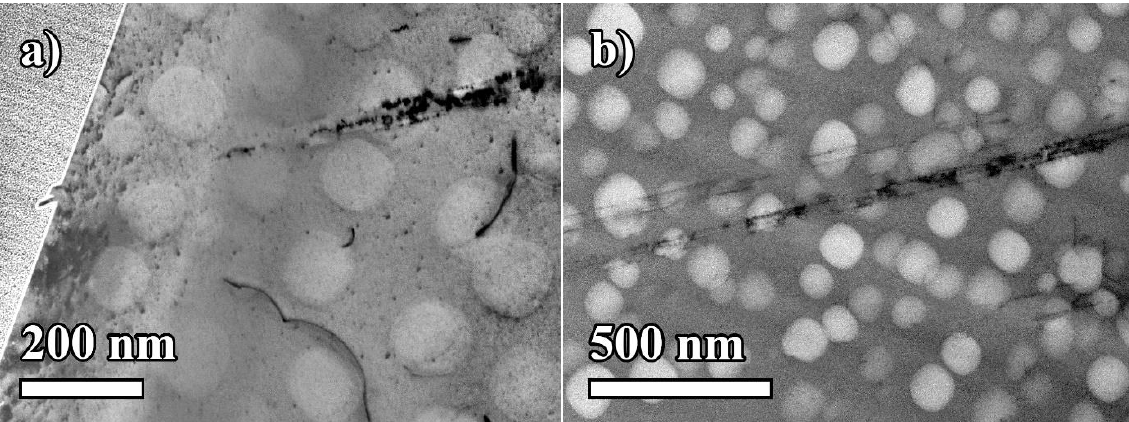
Figure 8. STEM micrographs of precipitation hardened superalloy RENE 41 after 10 cycles with strain amplitude ε a = 8 × 10 −3 ; ( a ) PSM consisting of an extrusion with PSB underneath the surface, ( b ) intensive slip bands (PSBs) shearing the precipitates.